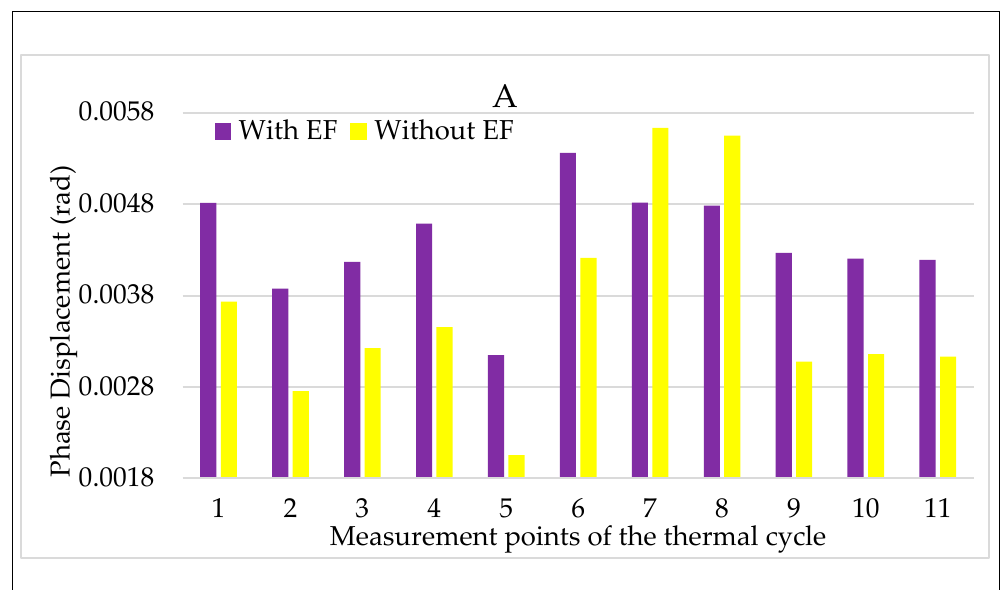
Figure 14. Phase displacement vs temperature + electric field for LPVT A.